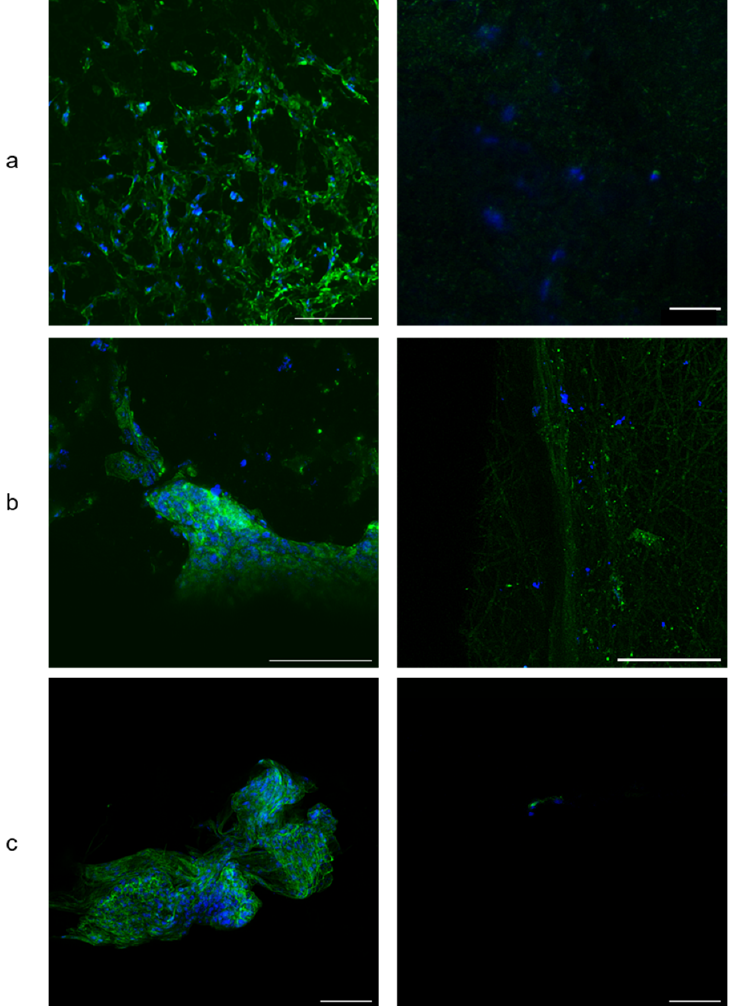
Figure 5. Human PDLCs morphology and spreading by CLSM. ( a / b / c ): 1st/2nd/3rd series under static ( left ) and dynamic ( right ) conditions. Actin cytoskeleton in green fluorescence and nuclei in blue fluorescence. Note that for series 2 ( b ), the gain for the Alexa 488 Phalloidin fluorescence was put on high in order to detect a signal for the dynamic condition. This resulted in the autofluorescence of the scaffolds fibers. Scale bars: 100 µm.